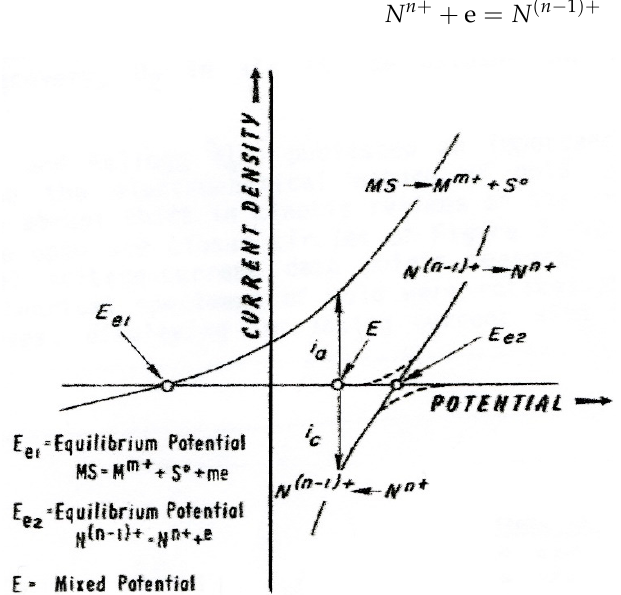
Figure 1. Current density potential diagram showing curves for metal sulfide with rest potential E e 1 and redox ions with rest potential E e 2 forming mixed potential E .